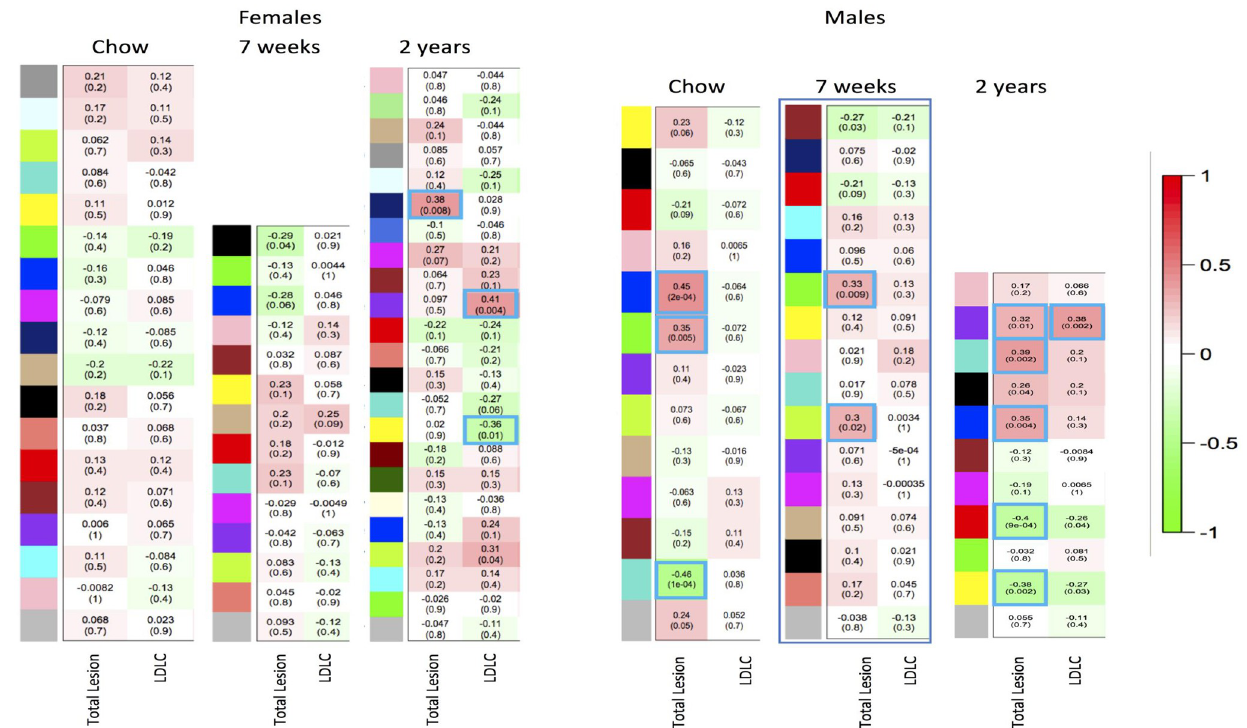
Fig 1. Modules for total lesion burden and LDLC. Each row corresponds to a module, the bottom column labels indicate total lesion burden or LDLC, and the top column label indicates timepoint. Numbers in each box indicate correlations with p values in parentheses. Positive correlations are indicated with red fill, negative with green fill, and significant modules are outlined